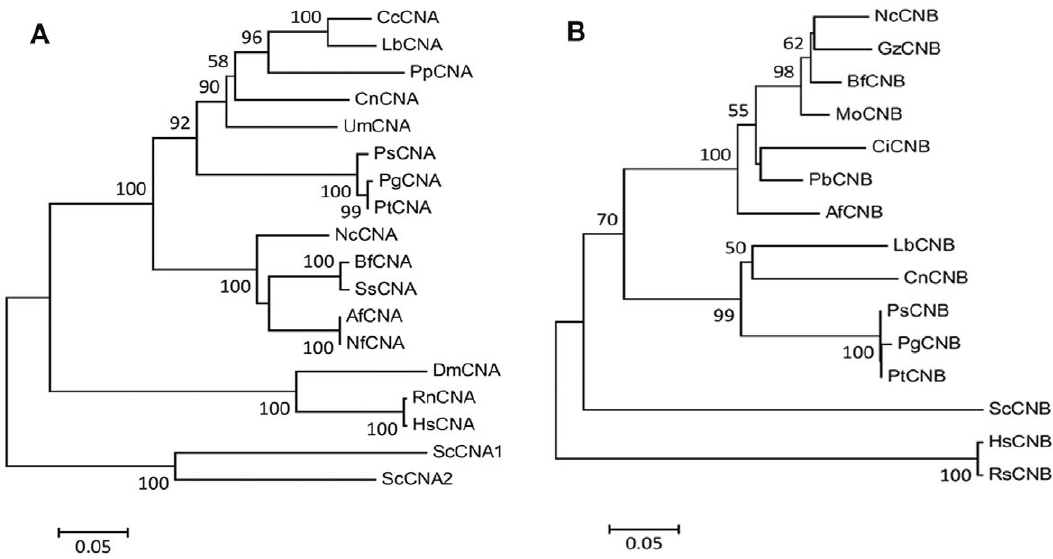
Figure 1. Phylogenetic analyses of CNA and CNB genes. A: Af CNA ( Aspergillus fumigatus , XP_753703), Bf CNA ( Botryotinia fuckeliana , XP_001558972), Cc CNA ( Coprinopsis cinerea , XP_001838986), Cn CNA ( Cryptococcus neoformans var. grubii , AAB97372), Dm CNA ( Drosophila melanogaster , NP_727985), Hs CNA ( Homo sapiens , NP_000936), Lb CNA ( Laccaria bicolor , XP_001884713), Nc CNA ( Neurospora crassa , XP_961193), Nf CNA ( Neosartorya fischeri , XP_001259754), Pg CNA ( Puccinia graminis f. sp. tritici , EFP89050), Pp CNA ( Postia placenta , XP_002470453), Ps CNA ( Puccinia striiformis f. sp. tritici , JX424819), Pt CNA ( Puccinia triticina , PTTG_07903), Rn CNA ( Rattus norvegicus , BAA14083), Sc CNA1 ( Saccharomyces cerevisiae , SCRG_04371), Sc CNA2 ( Saccharomyces cerevisiae , SCRG_01842), Ss CNA ( Sclerotinia sclerotiorum , XP_001597594), Um CNA ( Ustilago maydis ,